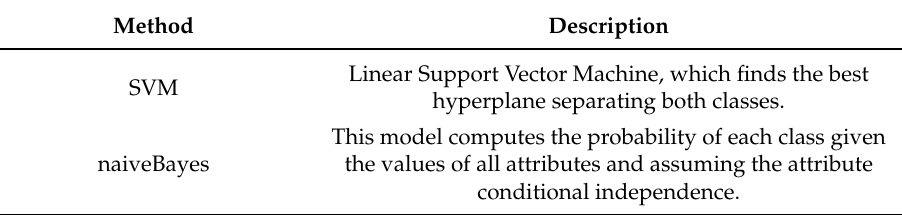
Table 2. Name and description of the methods used in the comparison of the approach